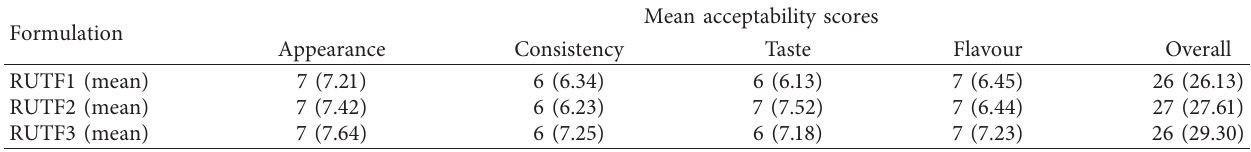
Table 4: Average and mean acceptability scores of the formulated ready-to-use therapeutic